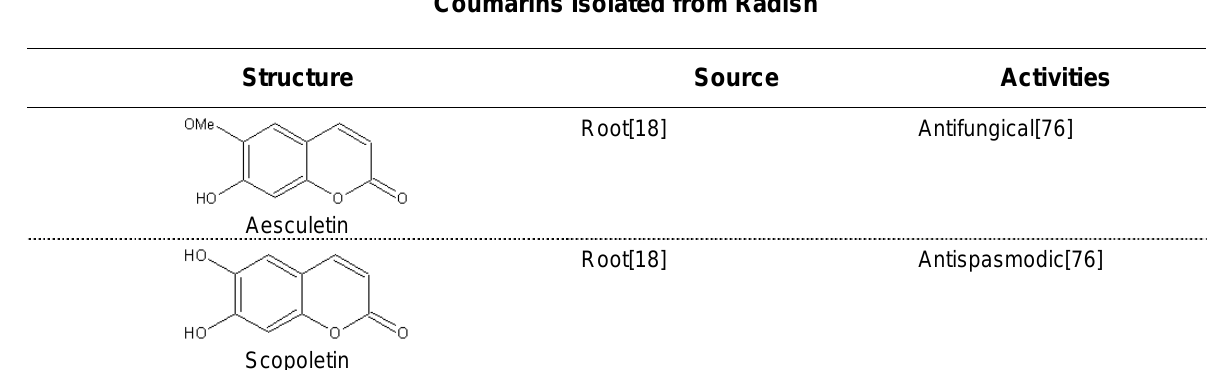
Coumarins Isolated from